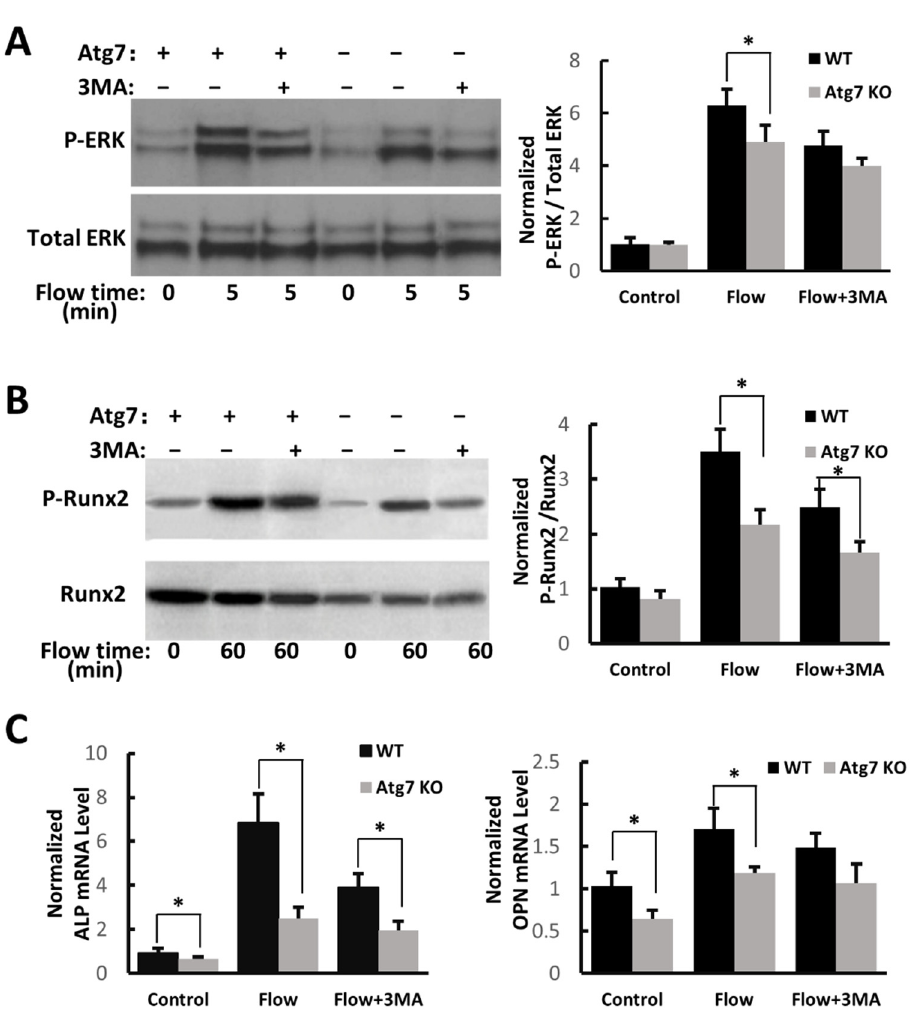
Figure 4. Autophagy deficiency affects mechanical loading-induced osteoblast responses. ( A ) Western blot of ERK1/2 phosphorylation in WT and Atg7 KO osteoblasts with and without 3 MA. ( B ) Western blot of Runx2 phosphorylation in WT and Atg7 KO osteoblasts with and without 3 MA. ( C ) Quantified mRNA levels of ALP, and osteopontin. ( n > 3, * p < 0.05; each bar represents the mean ± SEM).